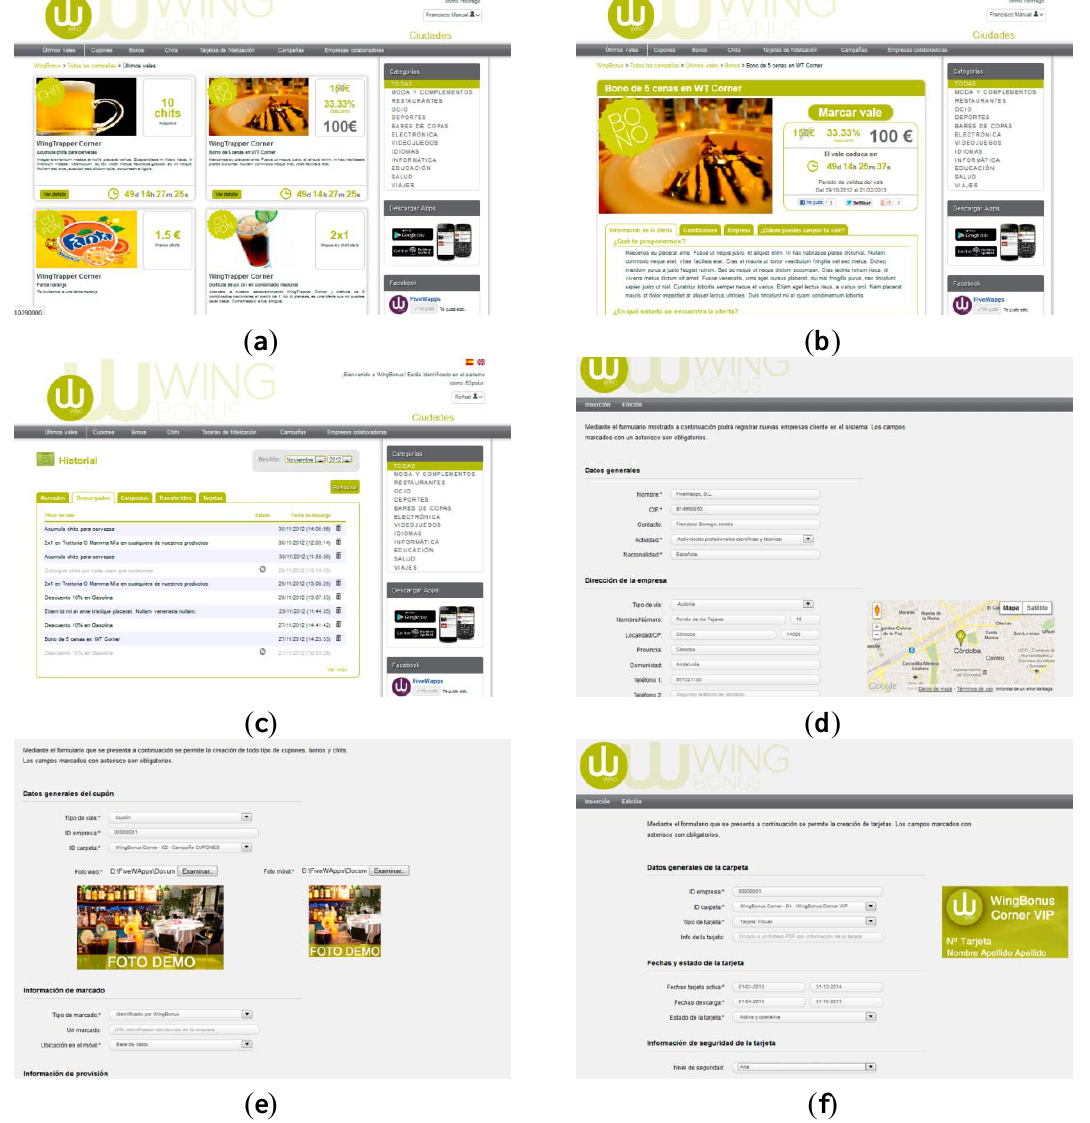
Figure 4. Some snapshots of the WingBonus